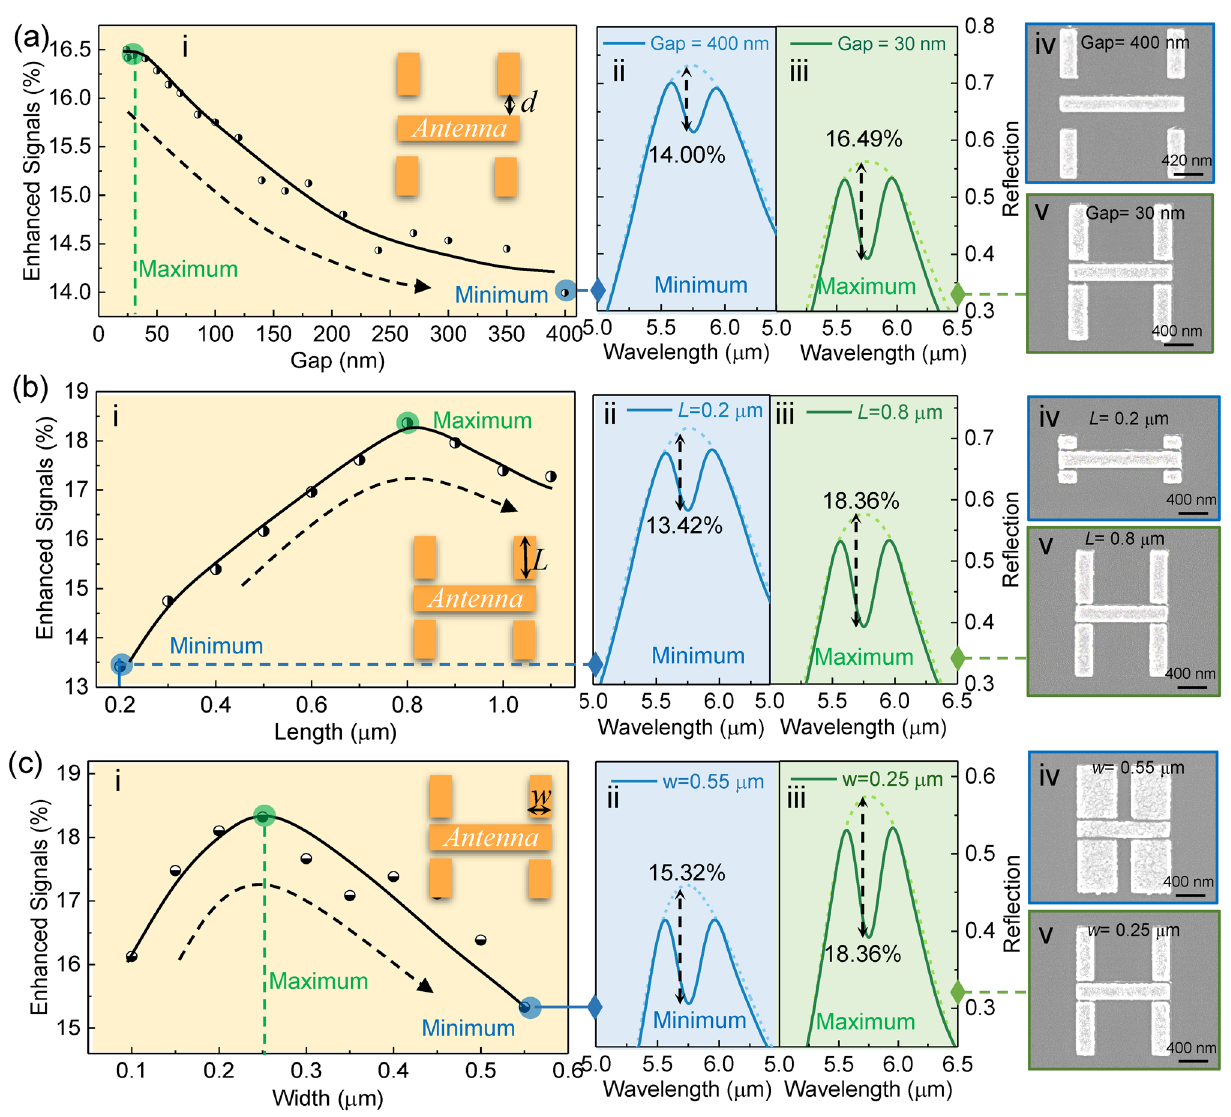
Fig. 3 Dimension optimization of dark mode antennas in multi-hotspot strategy. a Influence of nanogap size on molecular signal enhancement (analyte: 40 nm thick PMMA). i: profile curve of signal enhancement versus nanogap size d ; ii: simulated spectrum corresponding to mini- mum signal enhancement; iii: simulated spectrum corresponding to maximum signal enhancement; iv, v: SEM image. b Influence of dark mode antenna length L on molecular signal enhancement. c Influence of dark mode antenna width w on molecular signal enhancement. Dotted line: the baselines of